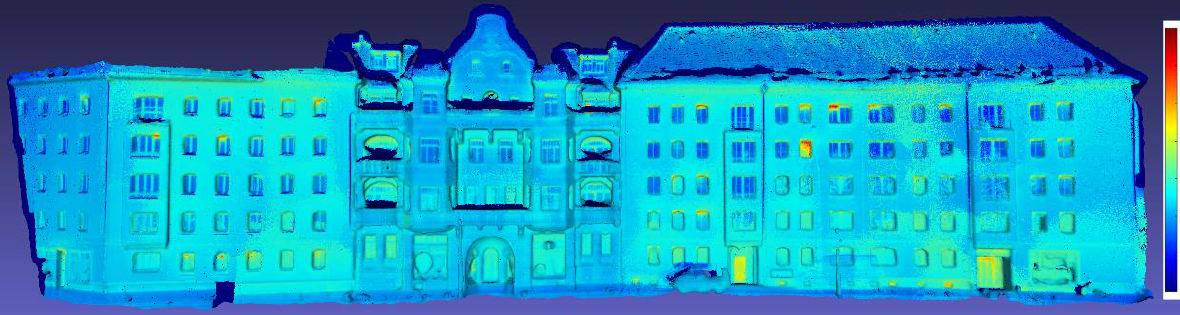
Figure 6. Texture mapping results after temperature correction